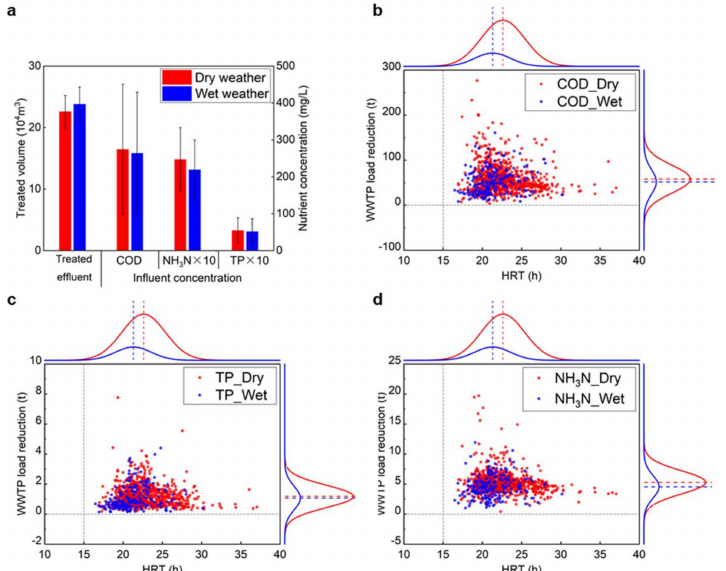
Figure 6. Wastewater treatment plants (WWTP) performance during dry and wet weather: ( a ) Histogram of treated volume and influent concentrations with standard deviations; ( b ) chemical oxygen demand (COD), ( c ) total phosphorus (TP), and ( d ) ammonia nitrogen (NH 3 N) load reduction versus hydraulic retention time (HRT). Scatter plots with marginal distribution curves are created by three-year operational data for dry (red) and wet (blue) periods.